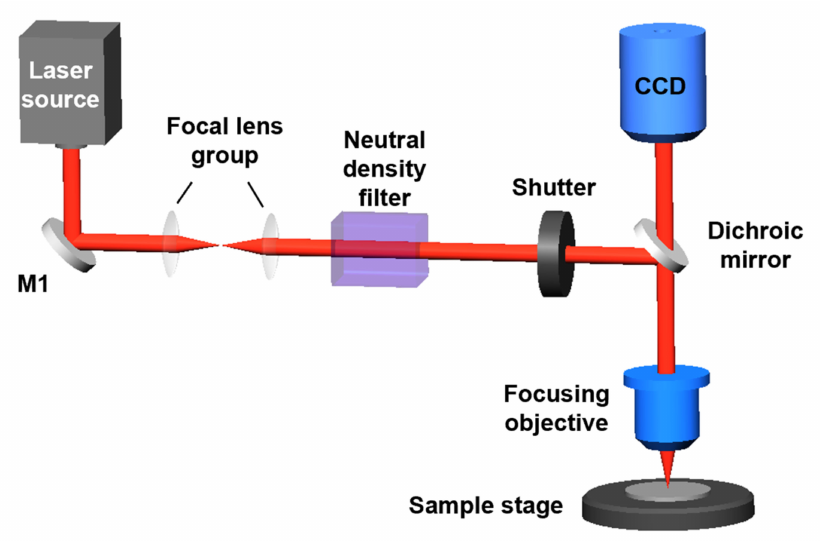
Figure 1. Schematic diagram of the experimental setup for the generation of laser-induced periodic surface structures (LIPSSs). CCD: charge-coupled